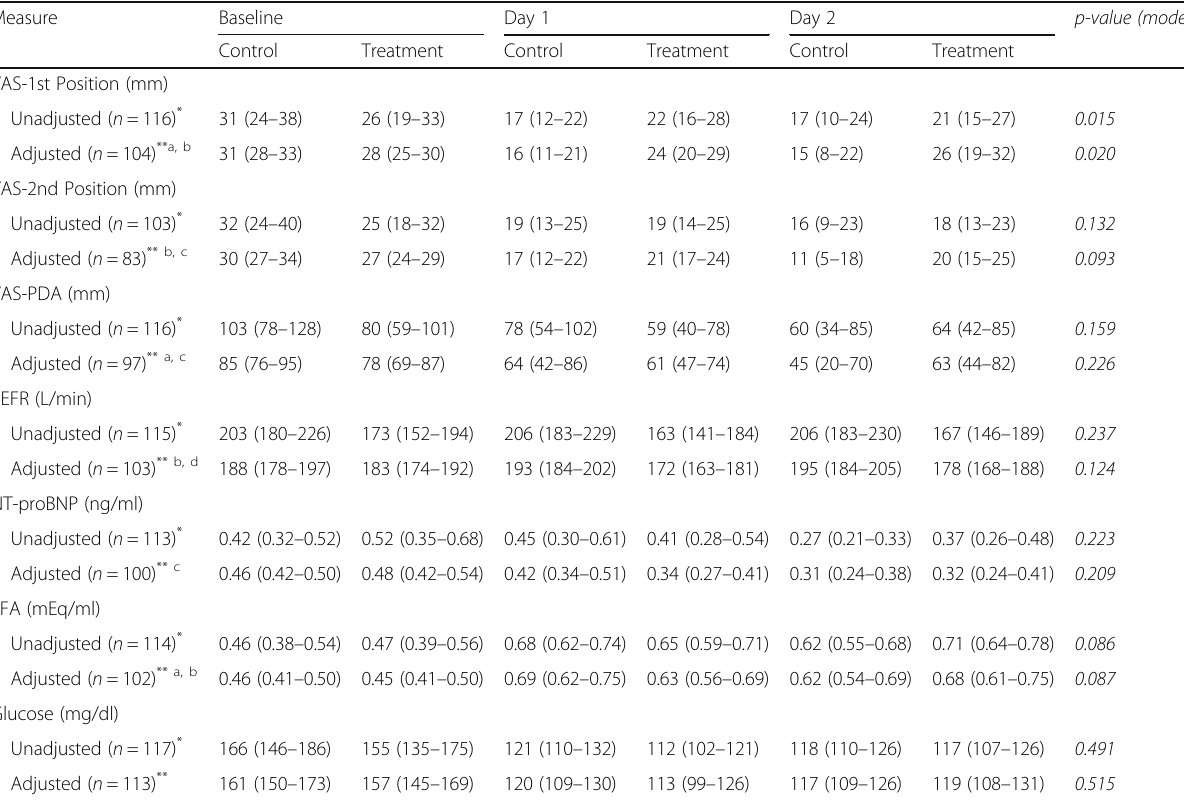
Table 3 Physiologic outcomes by thiamine supplementation over time Measure Baseline Day 1